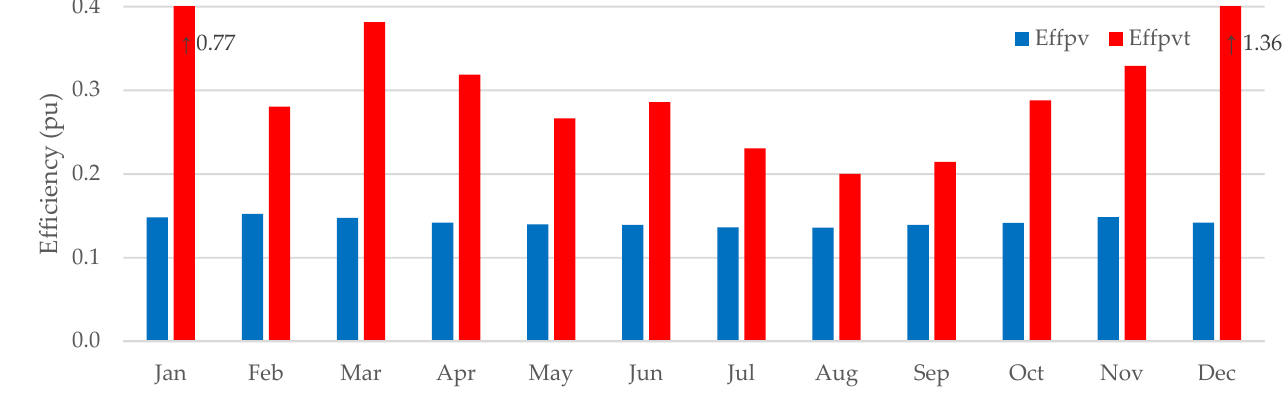
Figure 16. Monthly average daily PV module and PVT collector conversion